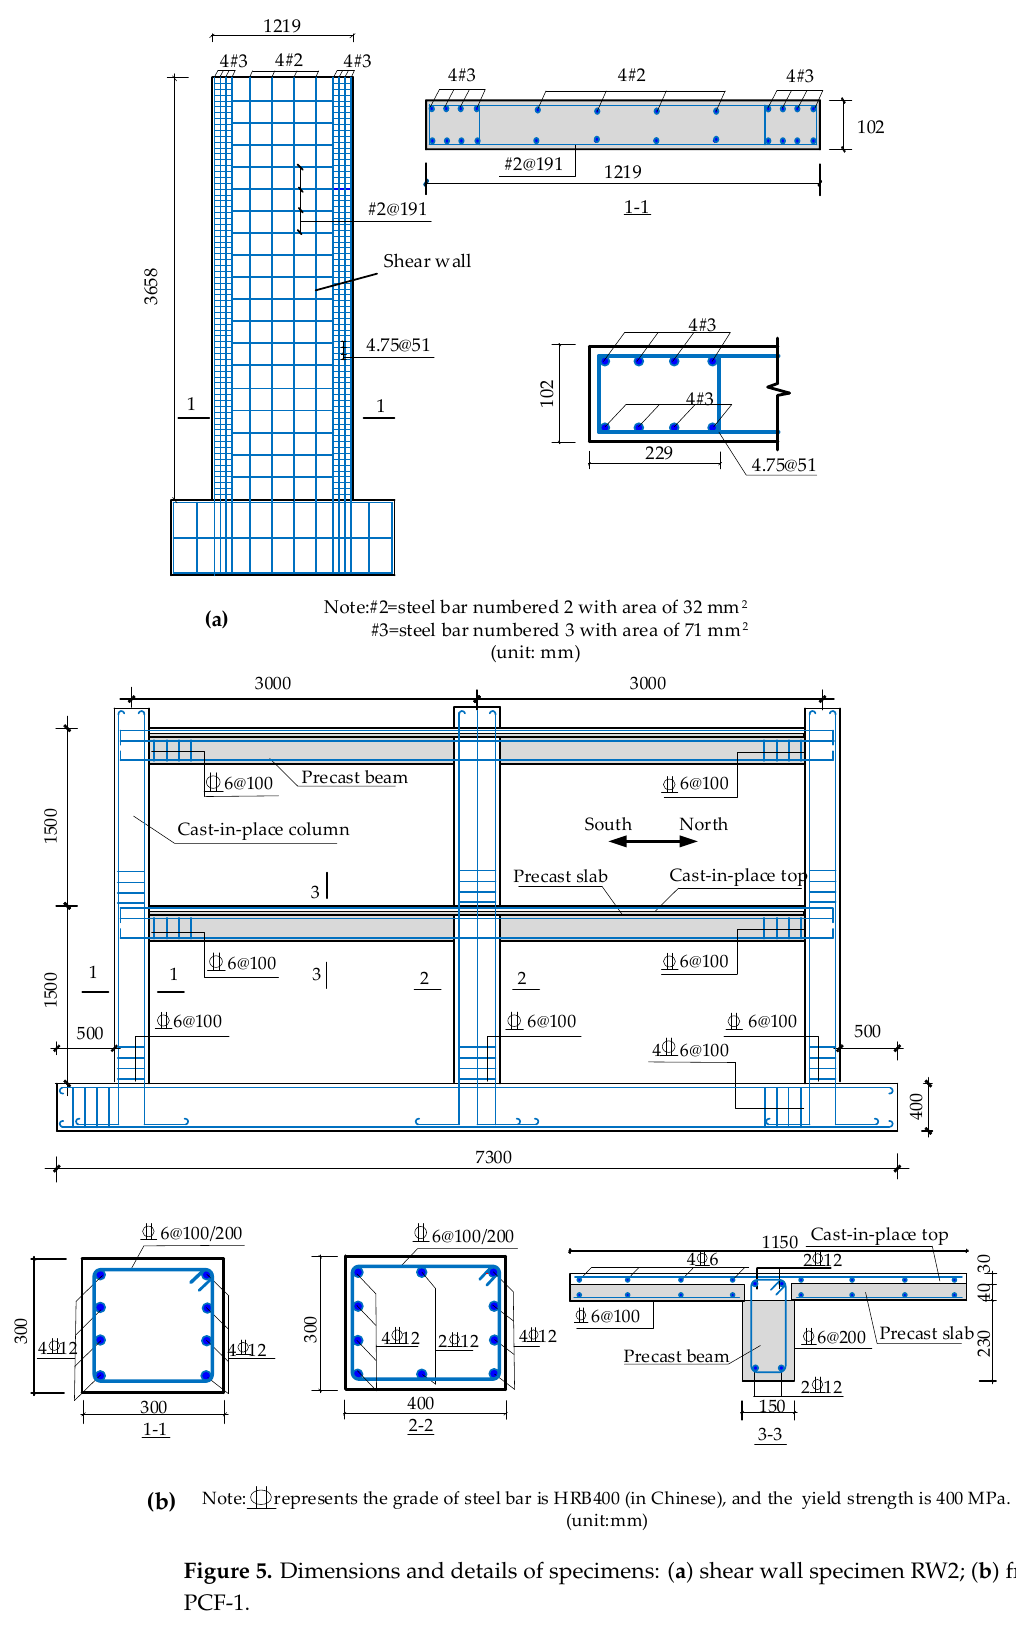
Figure 5. Dimensions and details of specimens: ( a ) shear wall specimen RW2; ( b ) frame specimen PCF-1. For the shear wall specimen RW2, a constant and uniform vertical pressure was ap- plied on the top area of the wall first, and then applied a horizontal monotonic load to the left endpoint on the top of the wall, using the displacement control method. The load- displacement curve of FEA and test are illustrated in Figure 6a, which matched well. At the same time, the failure modes of the test and FEA are presented in Figure 7. The bottom right concrete of the shear wall in FEA reached the ultimate strength of 41.87 MPa and crushed, which was consistent with the experimental failure phenomenon in Figure 7a, indicating that the finite element model can simulate the mechanical performance of the shear wall well.